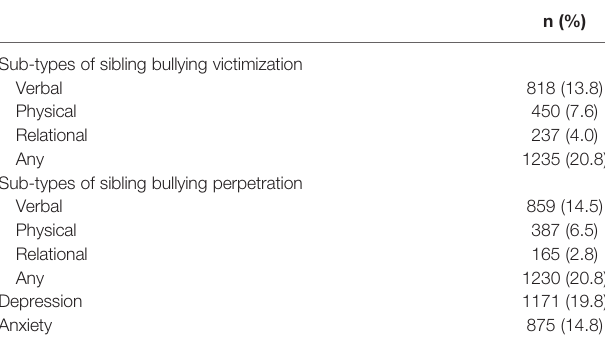
TABLE 1 | The prevalence of sub-types of sibling bullying involvement, depression, and anxiety (N = 5,926).